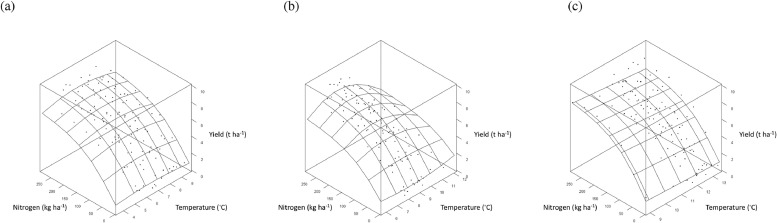
Response surface (Eq. (4), Table 3) of the effect of applied nitrogen (kg N ha−1) on winter wheat grain yield (•, t ha−1 at 85% dry matter) from Section 1 (all with PKNaMg) of the Broadbalk Long Term Experiment, adjusted for cultivar Hereward, as affected by: (a) Mean November temperature; (b) Mean April temperature; (c) Mean May temperature. Similar 3-dimensional surface plots are provided in Supplementary Figure 1 for the effect of rainfall.